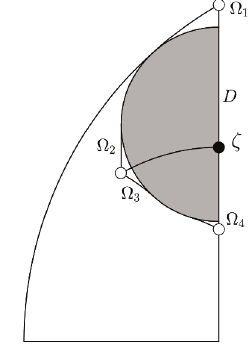
Figure 14. Orbit of the equilateral triangle (white points), orbit of the isosceles right triangle (black point), semicircle D , and region